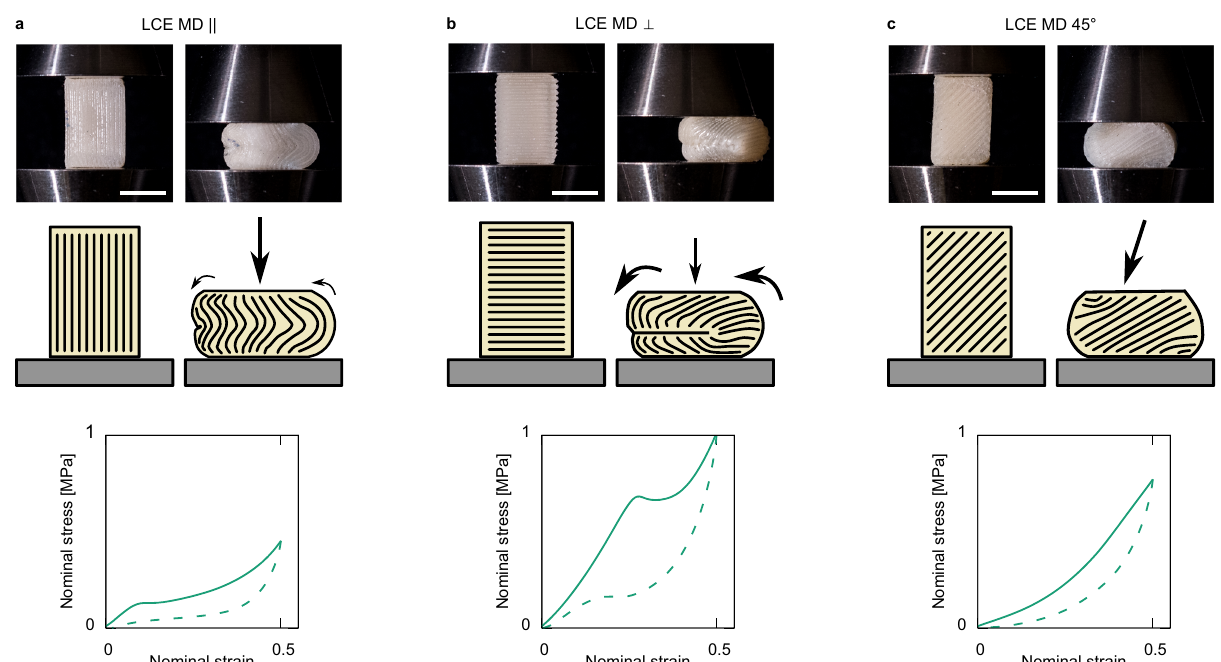
Fig. 5 Anisotropy-controlled buckling. Compression tests on high aspect ratio (height > in cross-sectional dimension) monodomain LCE devices with the director oriented ( a ) parallel, ( b ) perpendicular and ( c ) at 45° to the compression axis. Tuning the print axis in these devices enables further control of the buckling response and load curve shape of the DIW printed LCE devices. The fi gures show photographs to devices in their strained and unstrained states along will propose illustrations of the overall director pro fi le in each state — traced from the print lines visible in each device, and the compressive nominal stress — nominal strain load curves recorded for each test. Bars are 10